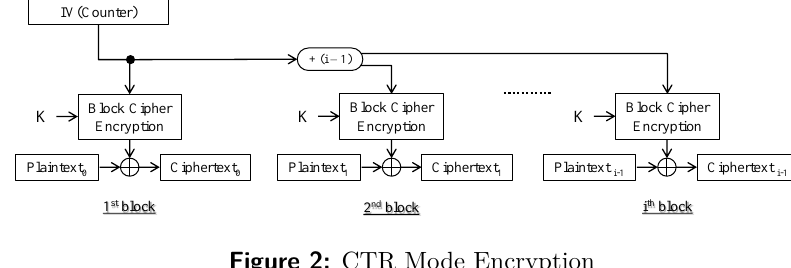
Figure 2: CTR Mode